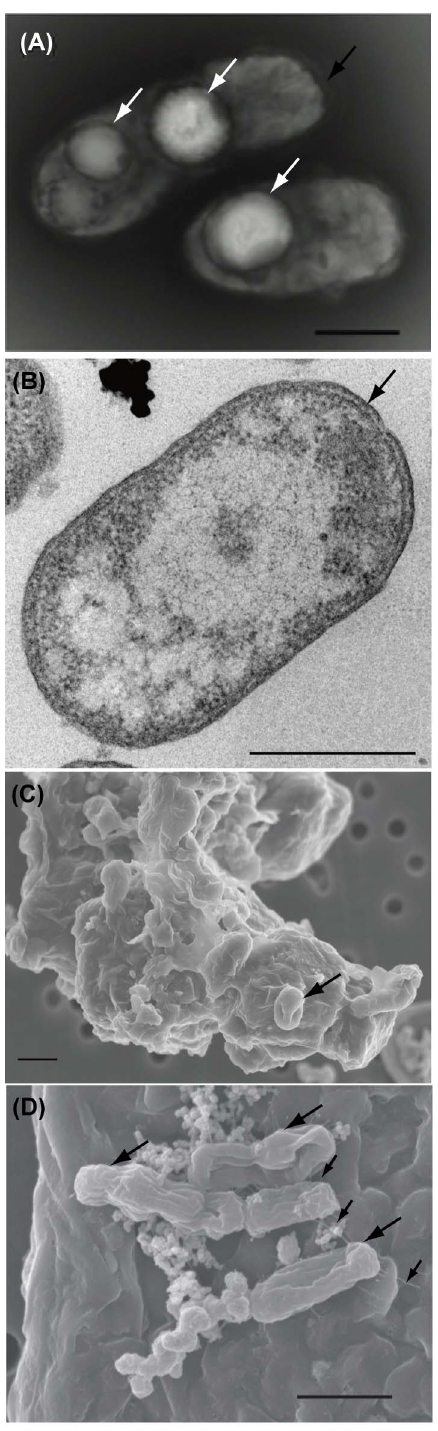
Figure 1. Electron micrographs of the new isolate strain Hiromi 1. A transmission electron micrograph of a negatively stained cell (A) and a thin section cell (B) grown under the chemolithoautotrophic condition. White and black arrows indicate intracellular particle and outer membrane, respectively. Scanning micrographs of cells adhering on elemental sulfur by pilus to biofilm (C, D). Cells attached on biofilm formation and pili structures were shown by large and small black arrows. Other cells grew under the polysaccharide-like substances. Bars, 0.2 m m (A), 0.5 m m (B) and 1 m m (C, D).